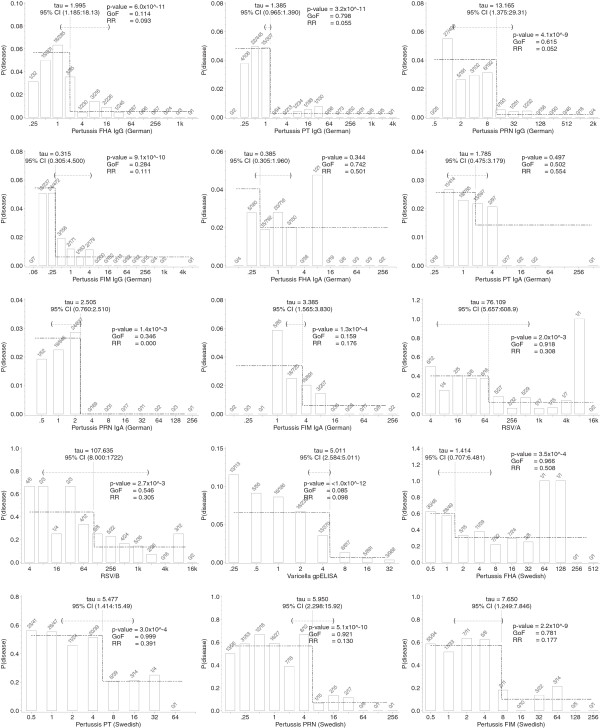
Illustration of fitted a:b model for the 15 datasets. Threshold values and 95% CIs for τ are superposed on the observed data showing the infection rates by titer value. The numbers above each bar show the number of cases of disease and the number of subjects at each binned assay value. Thresholds illustrated are those obtained by profile likelihood estimation. P-values refer to the modified likelihood ratio test with small values indicating statistical significance. GoF refers to the p-value of the goodness-of-fit test with small values implying a poor fit of the model to the data. RR is relative risk of infection above and below the threshold.